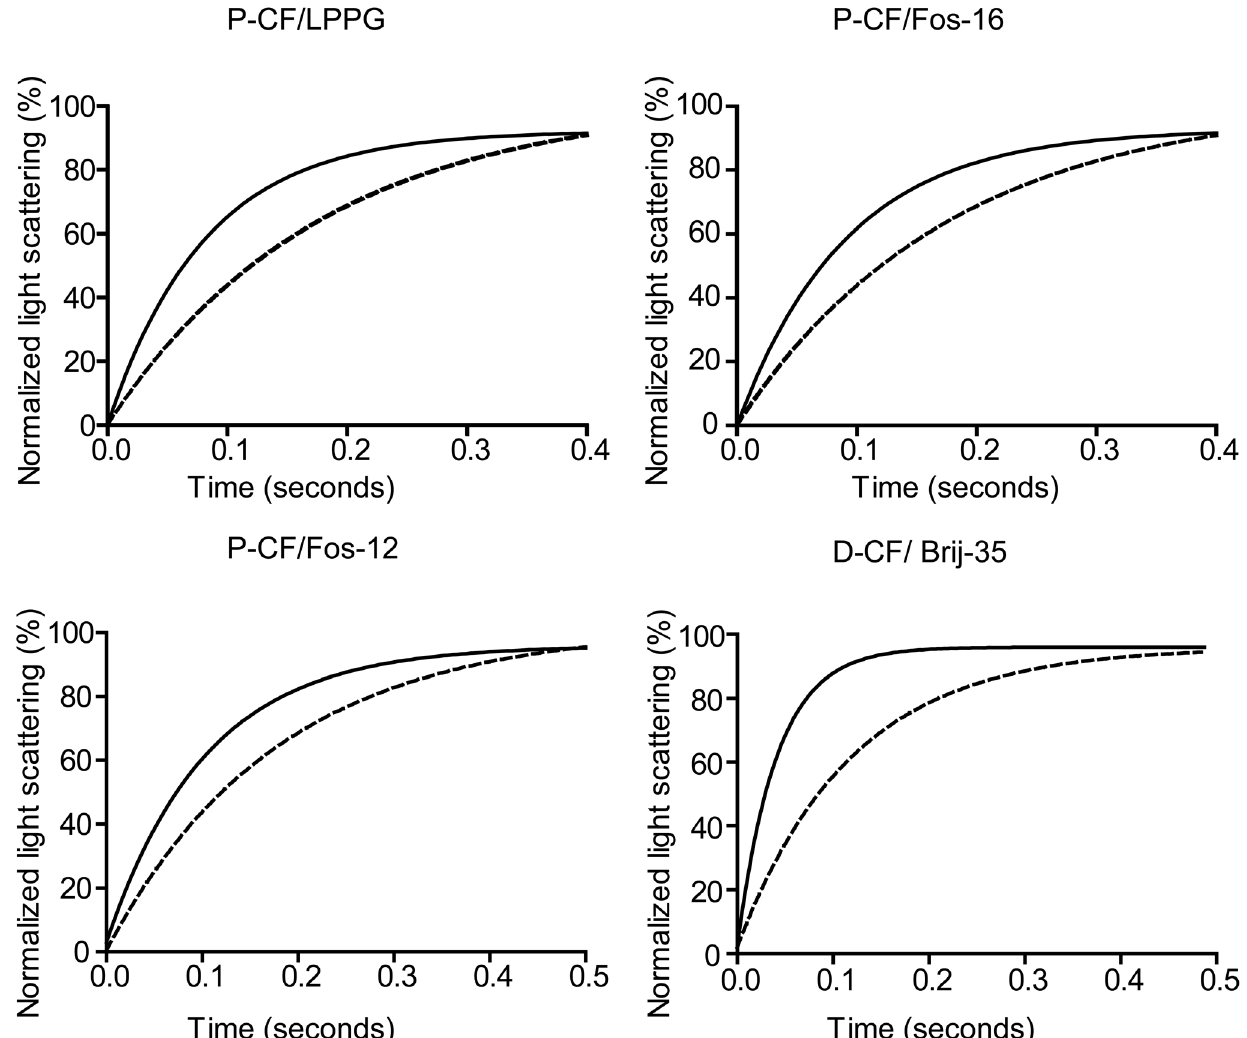
Figure 4. Water transport activity of P-CF and D-CF mode produced mAQP4 M23. Precipitates of P-CF produced mAQP4 M23 were resolubilized in the indicated detergents. The solubilized proteins were purified by Co 2 + -NTA chromatography, the initial detergent exchanged to 0.05% DDM and the samples were reconstituted into E. coli polar lipids. Water transport activity was determined by stopped-flow light scattering measurements of mAQP4 M23 proteoliposomes at 10 u C. A 200 mM osmotic gradient was established by rapidly mixing vesicles suspended in reconstitution buffer with an equal volume of reconstitution buffer + 400 mM sucrose. Data represent the average of three independent measurements. Fitted curves of mAQP4 M23 proteoliposome light scattering are shown. Solid line, mAQP4 M23 proteoliposomes; Dashed line, E. coli polar lipid empty liposomes.